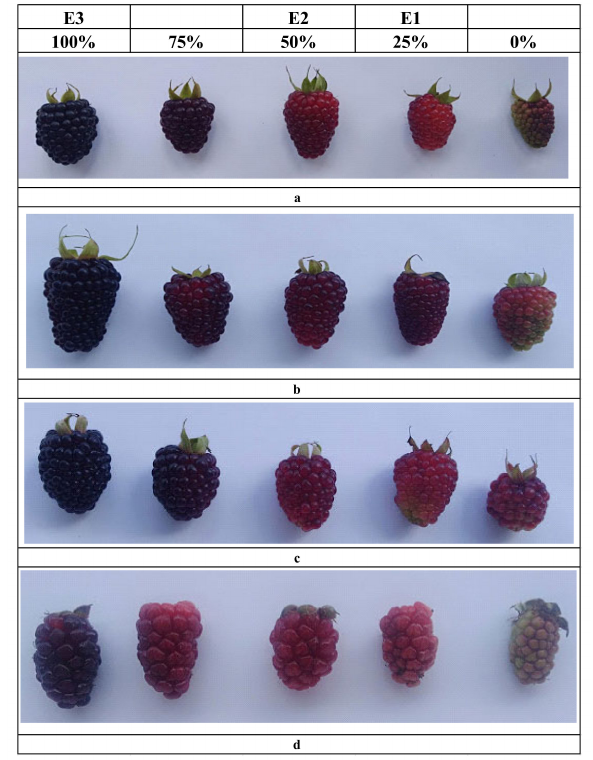
Figure 1. Photographs of blackberry (Rubus glaucus Benth) cultivars from Ecuador in di ff erent stages of maturity: ( a ) Blackberry Castilla variety, ( b ) Blackberry INIAP Andimora-2013 variety, ( c ) Blackberry Colombiana variety, and ( d ) Blackberry Brazos